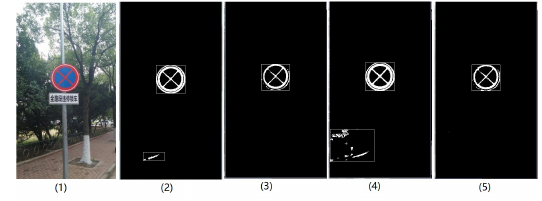
Figure 15: Different HSV Threshold Results